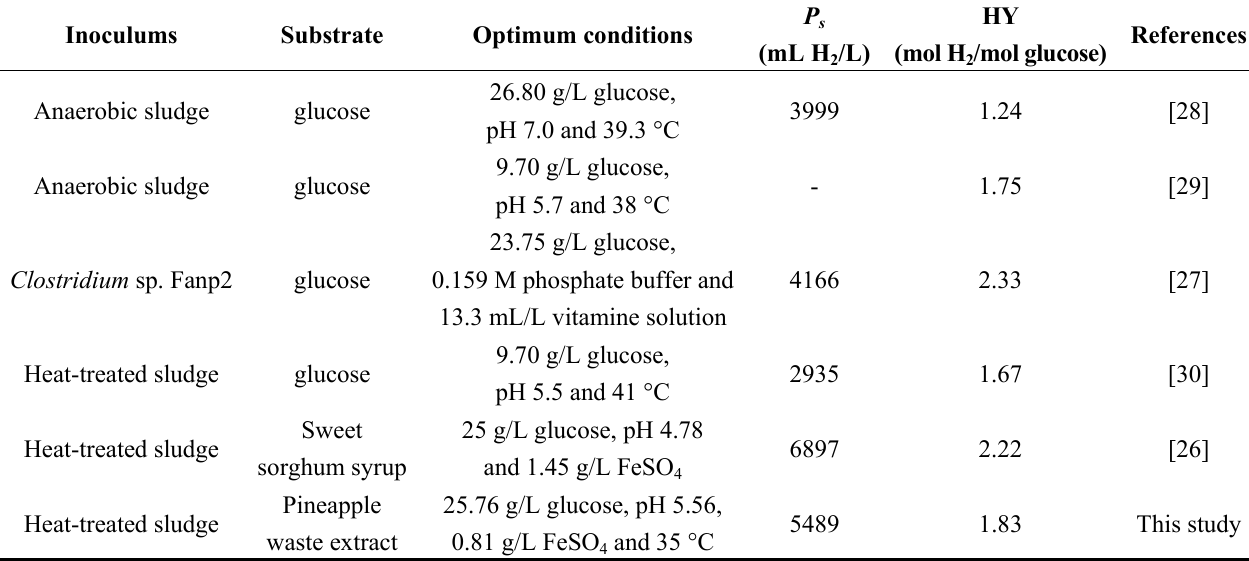
and HY at the optimum conditions with various inoculums and Table 6. Comparison of P s substrates in the experimental